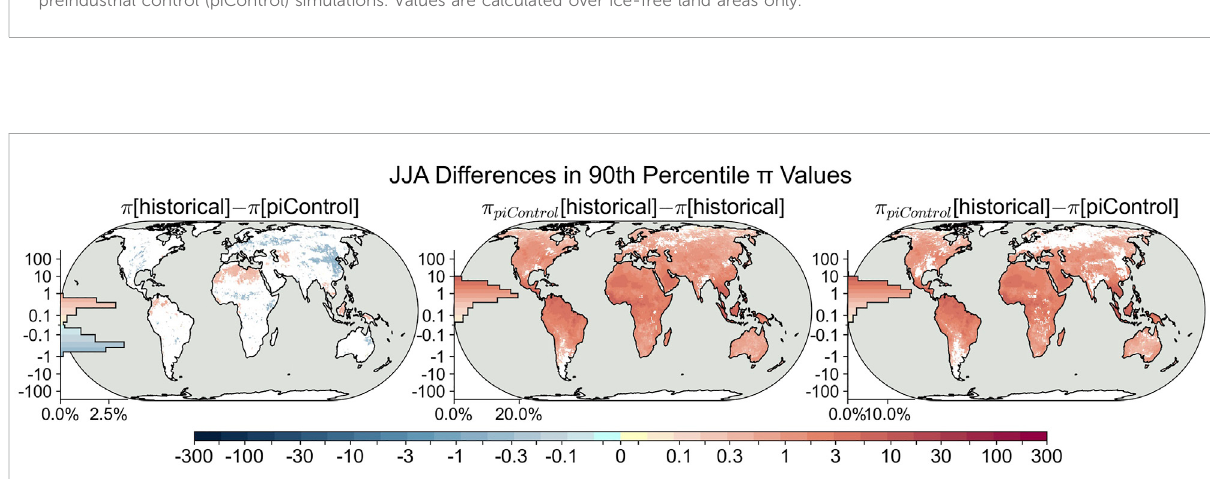
FIGURE 6 JJA multimodel median of differences in the 90th percentile values of π (dimensionless). The left map shows differences when π is calculated from the last 50 years ’ data from the historical simulations and π from piControl. The middle map shows the difference when means and standard deviations from the piControl climatology are used to calculate π for the late historical period versus using all climate statistics from the historical period. The right map shows the change from piControl to the late historical period when piControl climatology is used as the basis for calculating π inbothperiods.Areasaremaskedwheretheagreementamongmodelsonthesignofthechangeisbelowthe99%con fi dencelevel,or where the median of seasonal mean near-surface air temperature is below 0 ° C. Histograms show the probability distribution of signi fi cant changes as a fraction of the total land